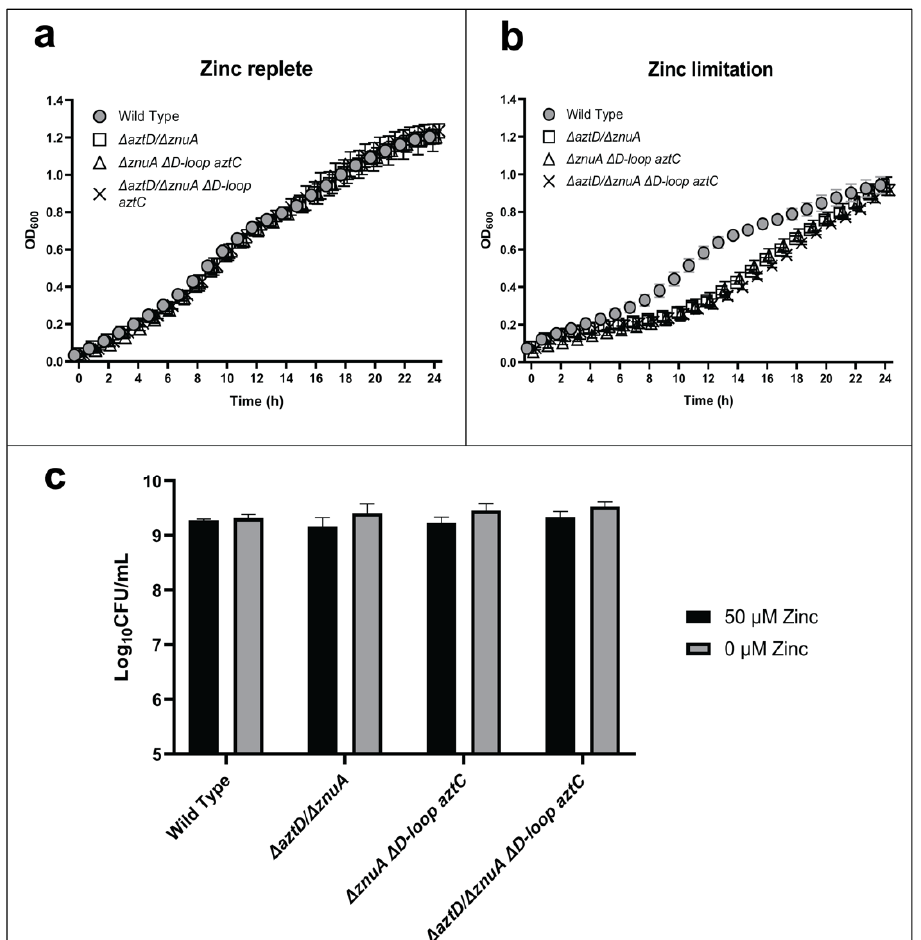
Figure 4. The role of AztD and the flexible loop of AztC in zinc transport. Growth curves at 600 nm in zinc-replete ( a ) or zinc-depleted ( b ) conditions for 24 h. Cellular viability quantification after 48 h of incubation ( c ). Error bars represent the mean ± S.D. of triplicate experiments. For the CFU, two-way ANOVA was used followed by Tukey’s multiple comparison test to show there was no statistically significant difference in viability between the mutants and WT.